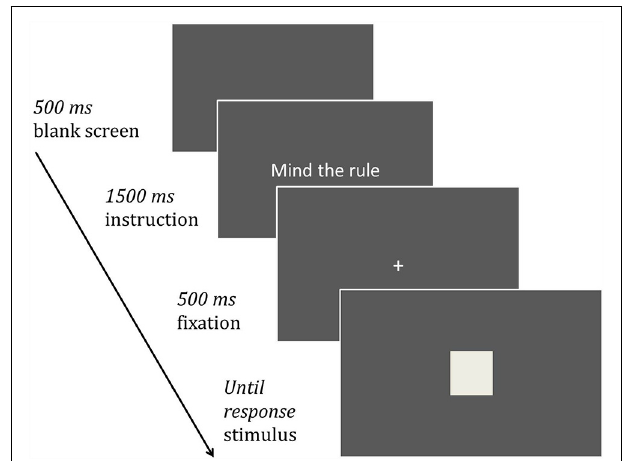
FIGURE 1 | Procedure of a trial. After the presentation of a blank screen for 500 ms, the participant is instructed by a short text for 1,500 ms. Then the presentation of a fixation cross for 500 ms follows whereafter the target stimulus is presented until the participant responds.